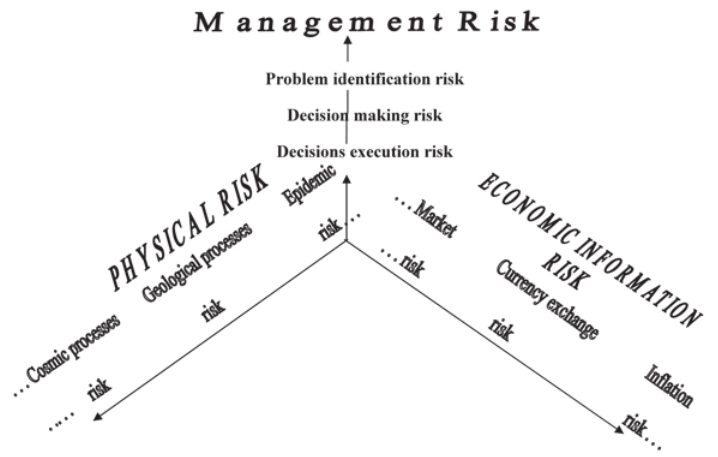
Fig 5. Common scheme of risk